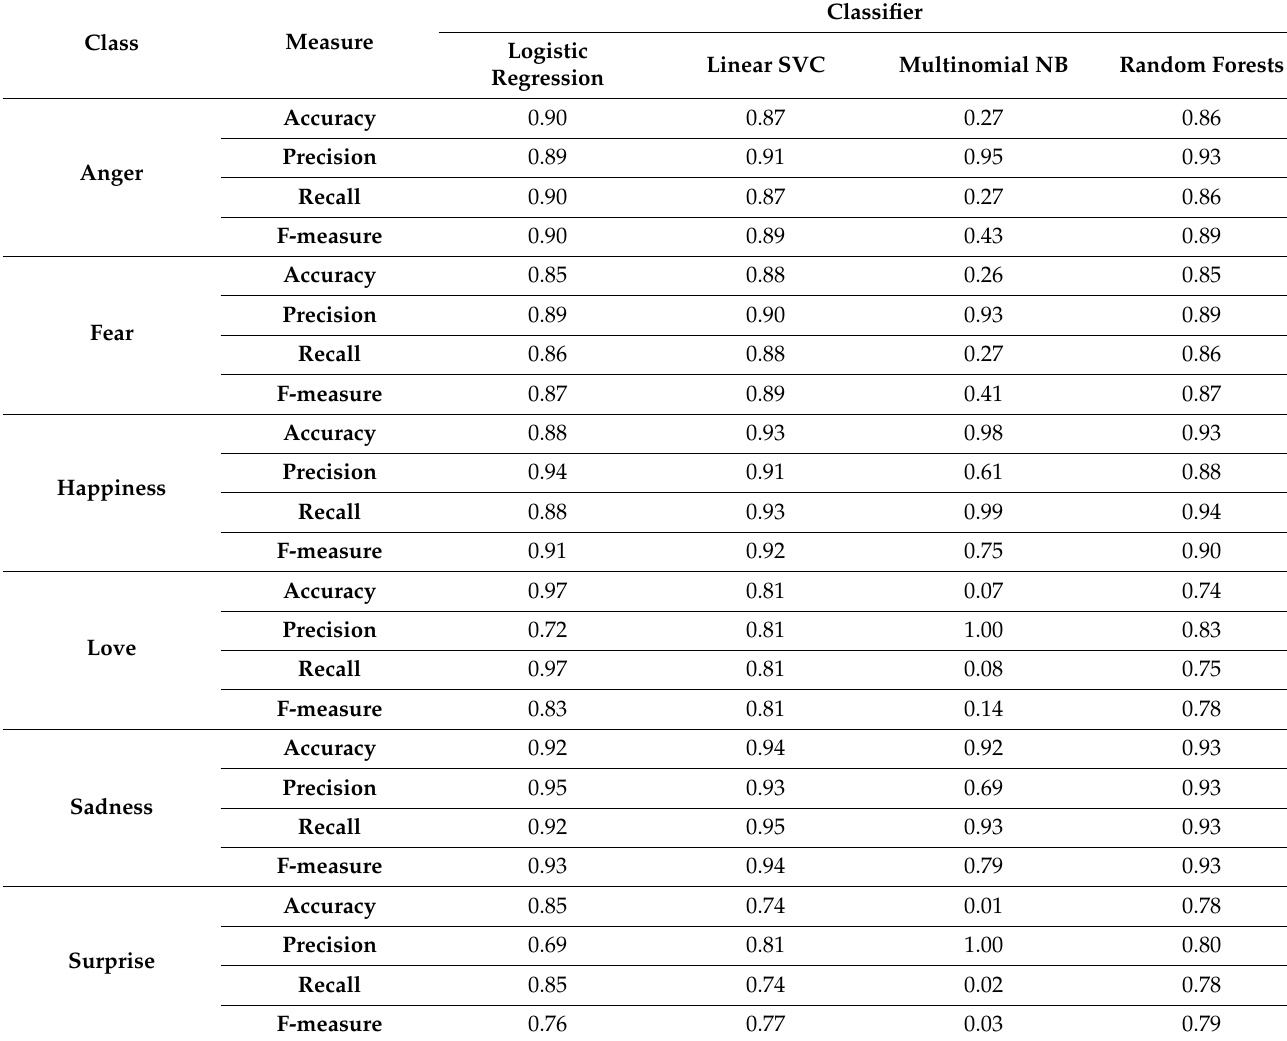
Table 10. Emotions classification experiments—Class-based